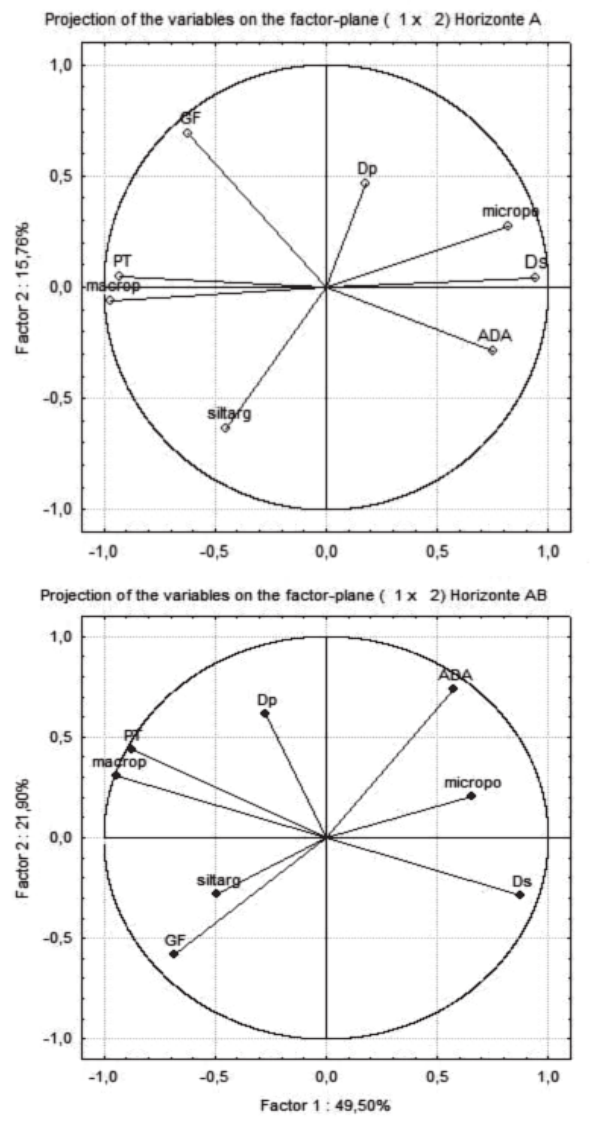
Figura 2. Gráfico da distribuição da nuvem de variáveis dos horizontes A e AB. Siltarg: relação silte/argila; GF: grau de floculação; macrop: macroporosidade; PT: porosidade total; Dp: densidade de partículas; ADA: argila dispersa densidade do solo.